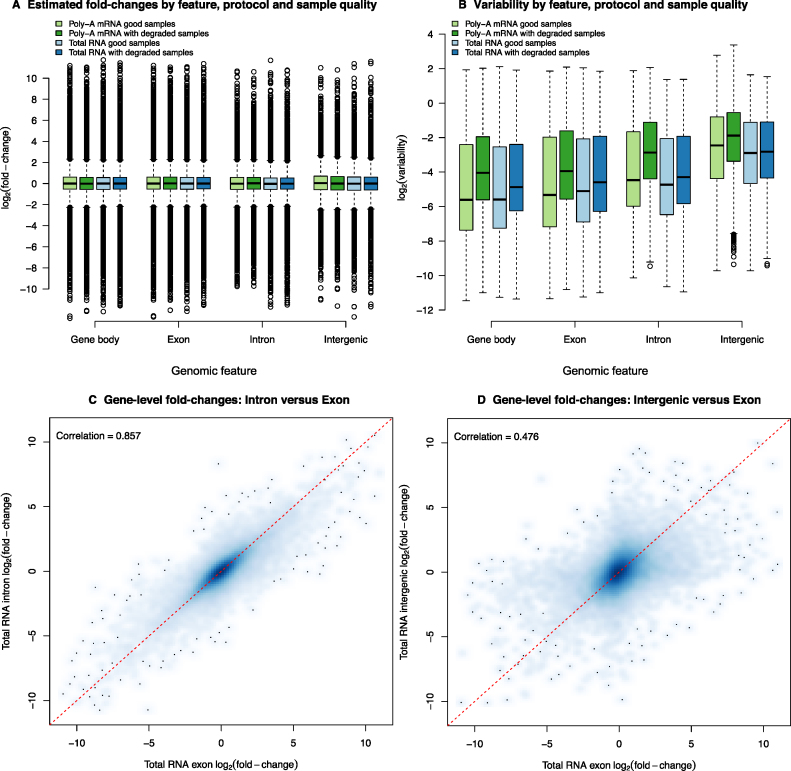
Exploration of signal and noise across different genomic features. (A) Estimated log-ratios (Mg) by protocol and degradation state obtained from nonlinear model fitted to reads that could be assigned to either the entire gene (i.e. overlapping anywhere from the start to the end), or exons only, or the signal left after subtracting the exon-level counts from the gene total (representing introns and unannotated exons), or intergenic regions. Very similar dynamic ranges of log-FC were observed for data obtained from all classes of features. (B) Variability (\documentclass[12pt]{minimal}
\usepackage{amsmath}
\usepackage{wasysym}
\usepackage{amsfonts}
\usepackage{amssymb}
\usepackage{amsbsy}
\usepackage{upgreek}
\usepackage{mathrsfs}
\setlength{\oddsidemargin}{-69pt}
\begin{document}
}{}$\log _2\hat{\phi }_g^2$\end{document}) by protocol and degradation state obtained from non-linear model fitted across the same feature classes shown in panel A. The level of variability from the model fits were generally comparable between counting strategies, although much higher for intergenic counts, which presumably pick up noise. (C) Smoothed scatter plot of estimated log-FC from the non-linear model fitted to the gene-level intron counts (y-axis) versus the log-FCs estimated from the gene-level exon counts for the total RNA data set, which had more intronic reads. (D) Smoothed scatter plot of estimated log-FCs from counts of neighboring intergenic regions (y-axis) versus the log-FCs estimated from the gene-level exon counts for the total RNA data set. The red dashed lines in panels C and D represent the equality line.